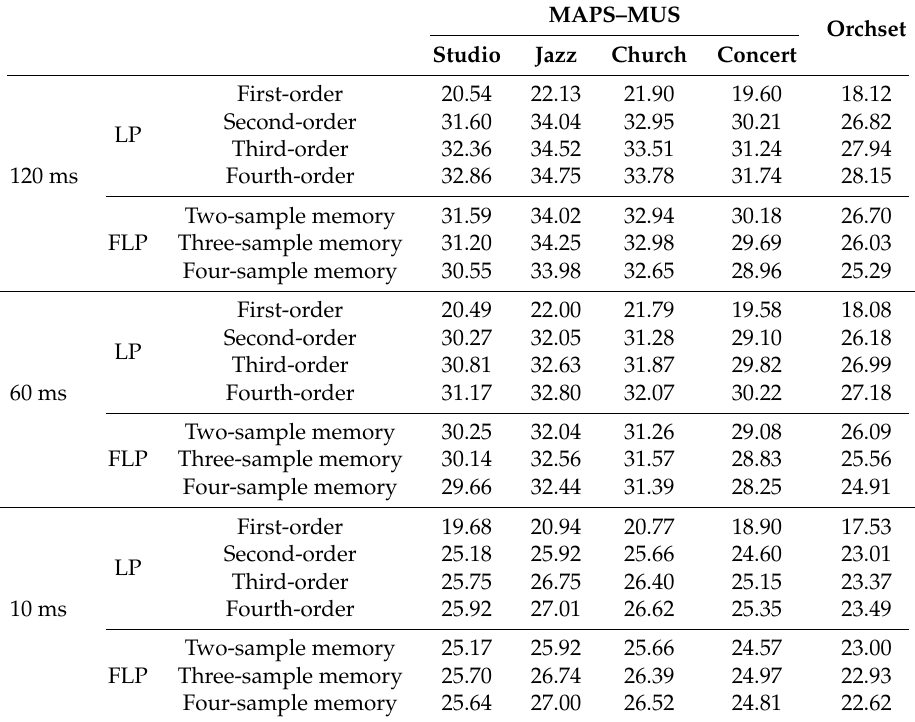
Table 3. Prediction gain (dB) for musical signal of classical music pieces played by piano (MAPS–MUS subset) and the classical music pieces performed by orchestra (Orchset